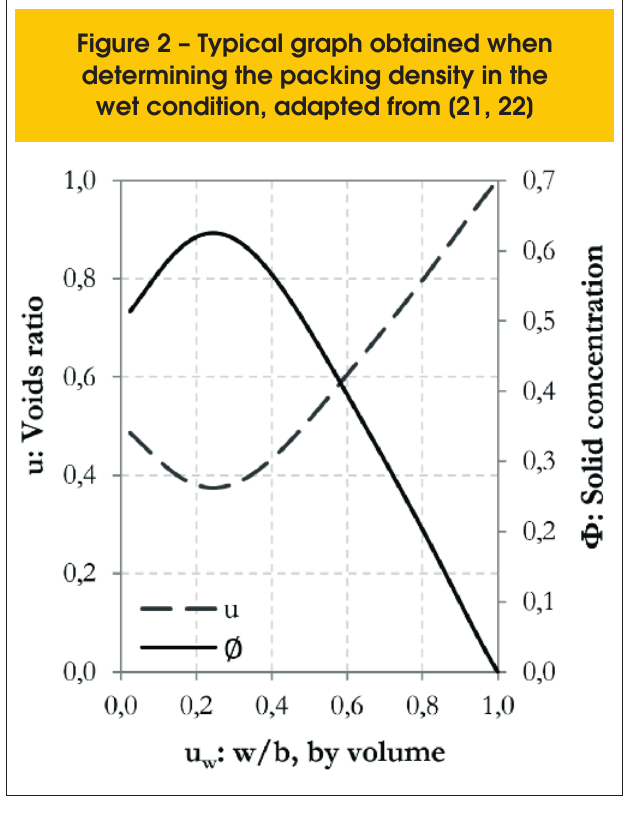
Figure 3 – Particle size distribution of cement and silica